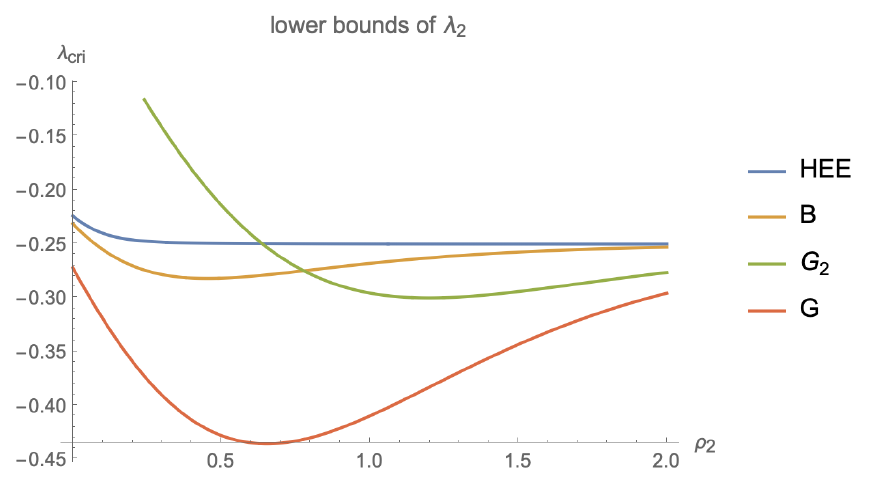
Figure 5 . Various lower bounds of the DGP parameter λ 2 for ρ 1 = 0 . 5 , λ 1 = 0 , d = 4 , i.e., λ 2 ≥ λ cri . The blue, orange, green, red curves denote the lower bounds derived from HEE (2.55), brand bending modes (2.48), effective Newton’s constants (2.8), respectively. Here 1 and G 1 , G 2 are the effective Newton’s constants on the two branes. It shows that the Newton’s constant G 2 and HEE impose the strongest constraint for ρ 2 < 0 . 638 , and ρ 2 > 0 . 638 , respectively. In the large tension limit ρ 2 → ∞ , all lower bounds approach to λ cri → − 1 / (2( d − 2)) .